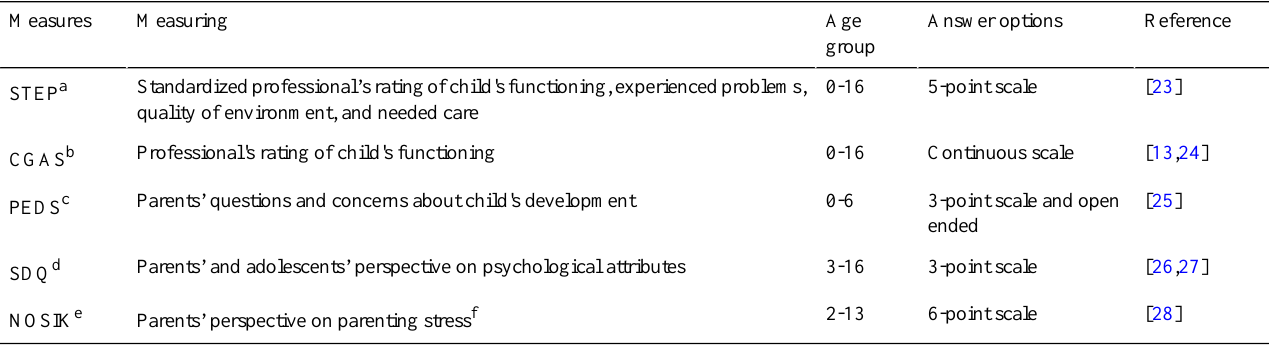
Table 1. Baseline measures for population